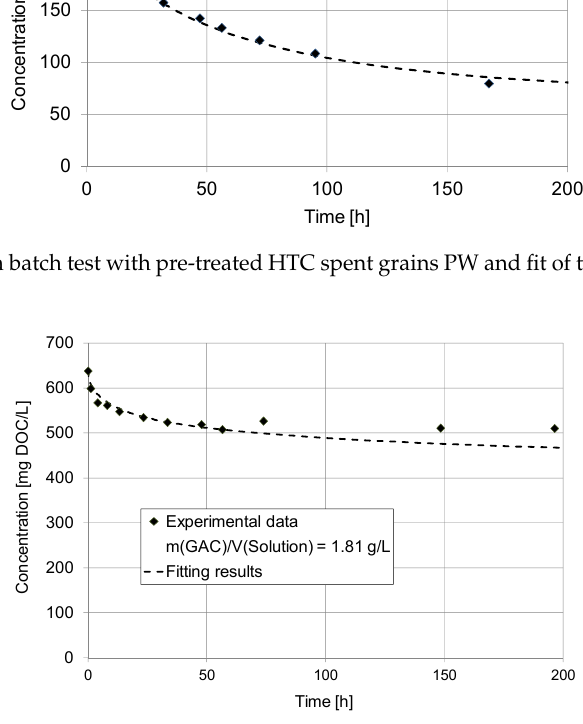
Figure 5. Data from a batch test with pre-treated HTC fine mulch PW and fit of the film-homogeneous diffusion model.